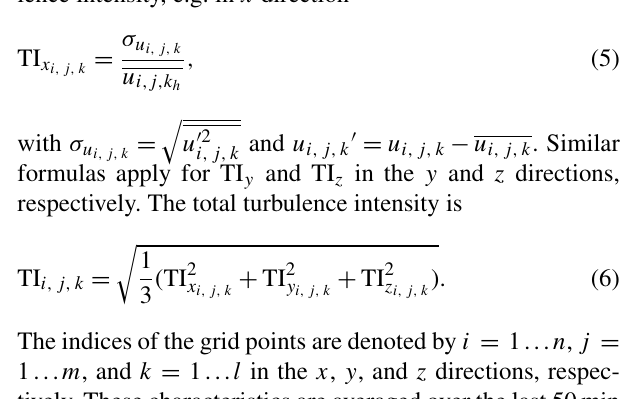
Figure 2. Schematic illustration of the top sector, the bottom sector, and the southern and northern sectors, defined from a view looking downwind from west to east towards the wind turbine on the disc. All sectors are 90 ◦ with 25m ≤ r ≤